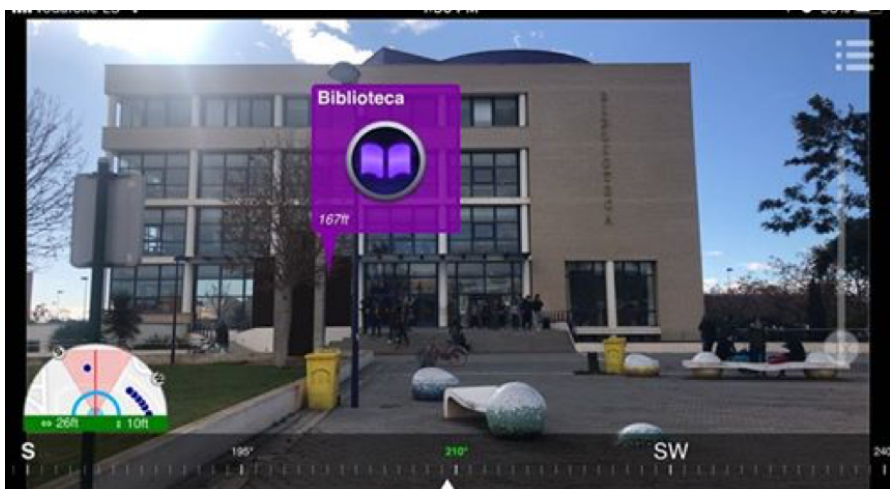
Figure 3. A screen-shot of the ARUJI app showing the library